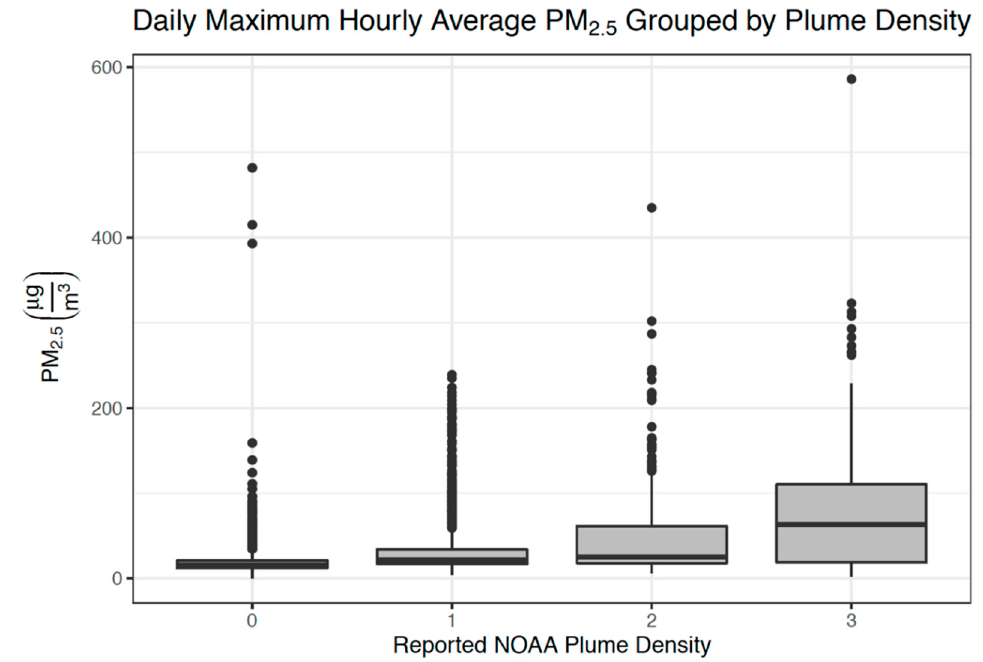
Figure 2. Box plot comparing ground-level PM 2.5 concentrations and smoke plume density categories for each day in the entire 2017–2018 California wildfire seasons. The thick line within each box represents the median value, and the top and bottom of each box represent the 75th and 25th percentiles, respectively. The whiskers end at the value within the data that is no more than 1.5 times the interquartile range away from the edge of the box, and the dots beyond these whiskers are outliers.